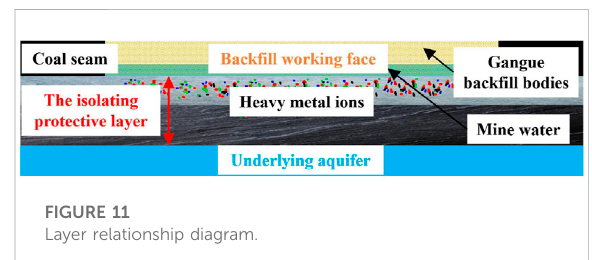
FIGURE 11 Layer relationship